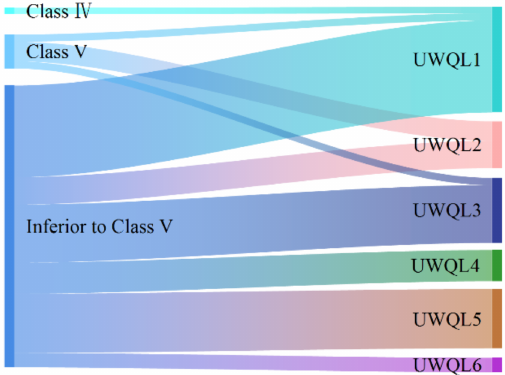
Figure 13. Sankey diagram of the water quality assessment results obtained based on the GB 2002-3838 standard versus the UWQLs obtained in this research, which were all based on in situ measurements of water quality parameters and R rs